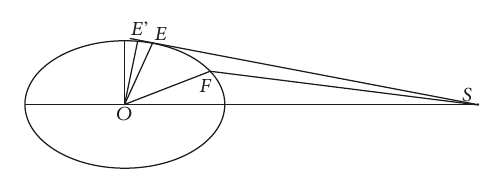
Figure 10: Sectional view of the area coverage of the